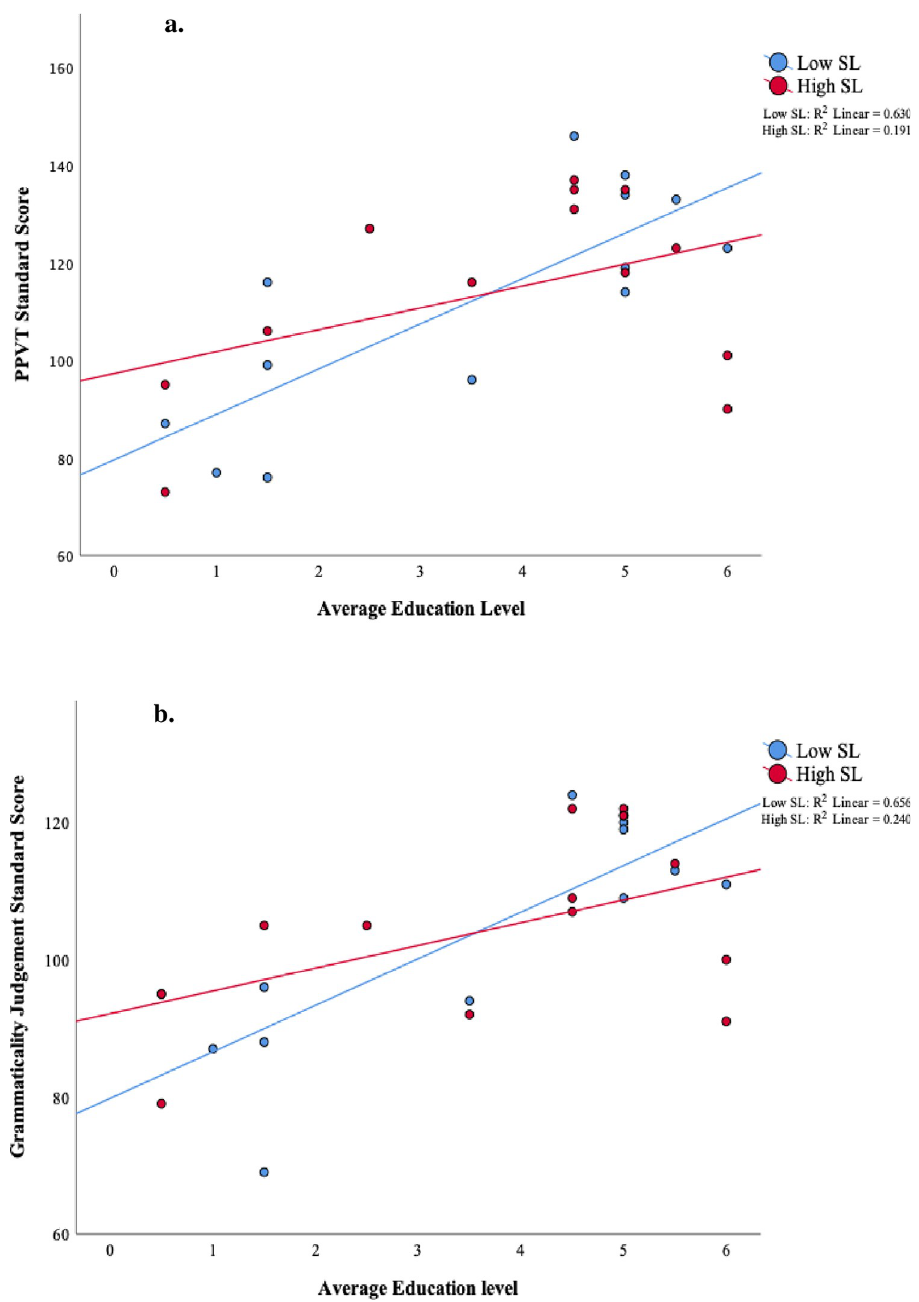
Fig 6. The significant interaction between parental education and statistical learning performance in the second half of the task. Scatter plots of (a) PPVT and (b) grammaticality judgement scores vs. parental education for low statistical learning and high statistical learning (as measured by ERP amplitudes) during the second half of the task. For illustration, the statistical learning variable was separated into low and high levels by a median split. Parents’ average education level: 0 = Less than High School, 2 = Some college, 4 = Bachelor’s degree, 6 = PhD/professional